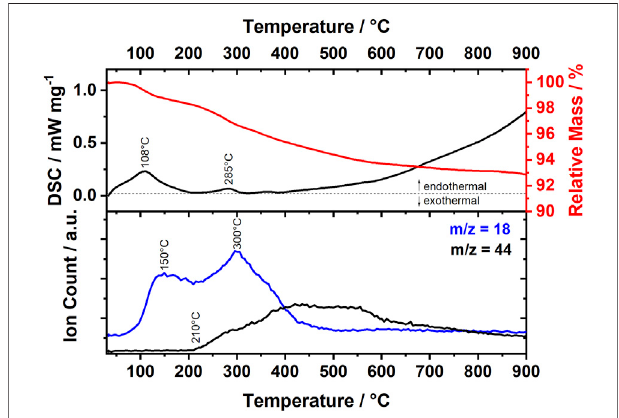
FIGURE 5 | Operando TGA-DSC-MS calcination in